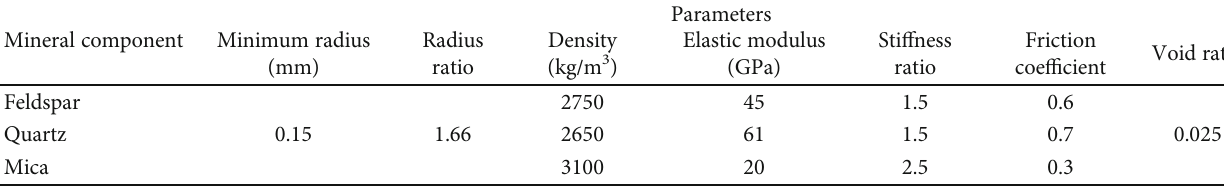
Table 2: Mesoscopic parameters of particles of di ff erent components.